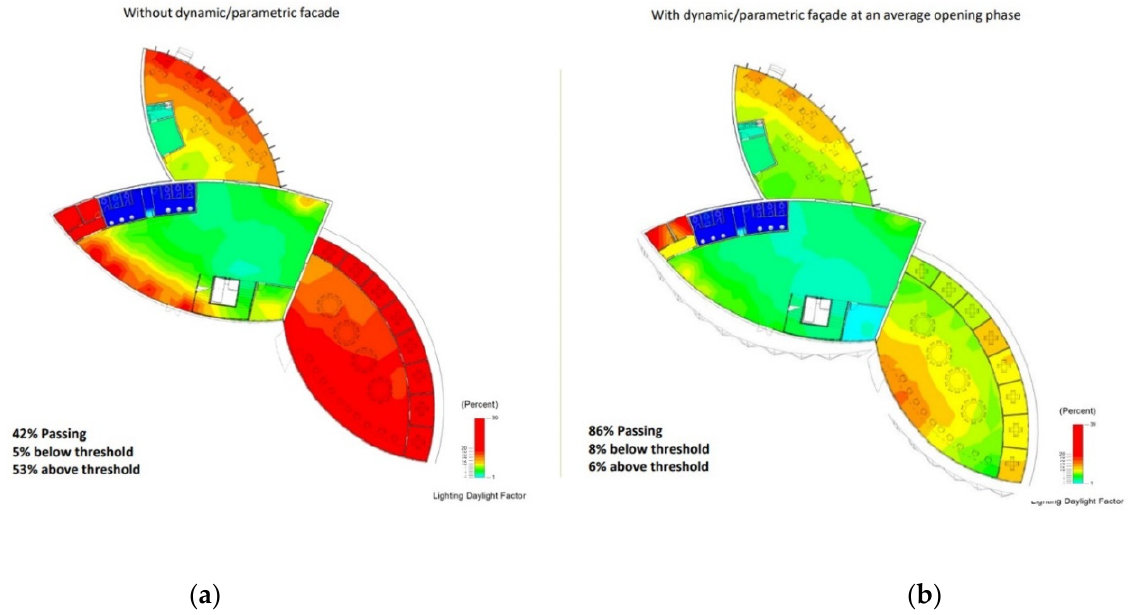
Figure 23. Indoor direct/indirect natural light analysis, ( a ) without façade, ( b ) with façade.